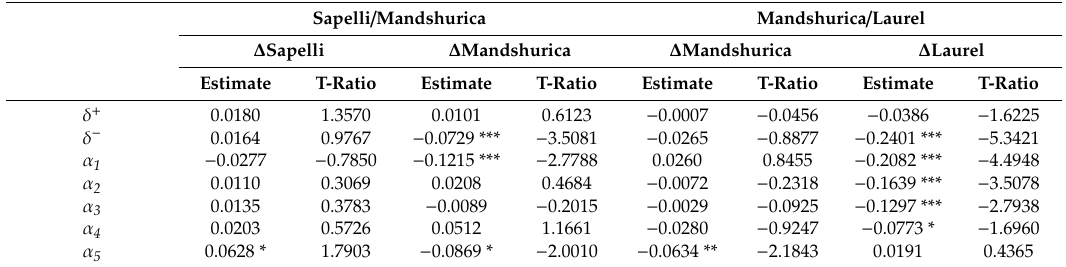
Table 7. Results of the threshold error correction model for the first subperiod. Sapelli / Mandshurica Mandshurica / Laurel ∆ Sapelli ∆